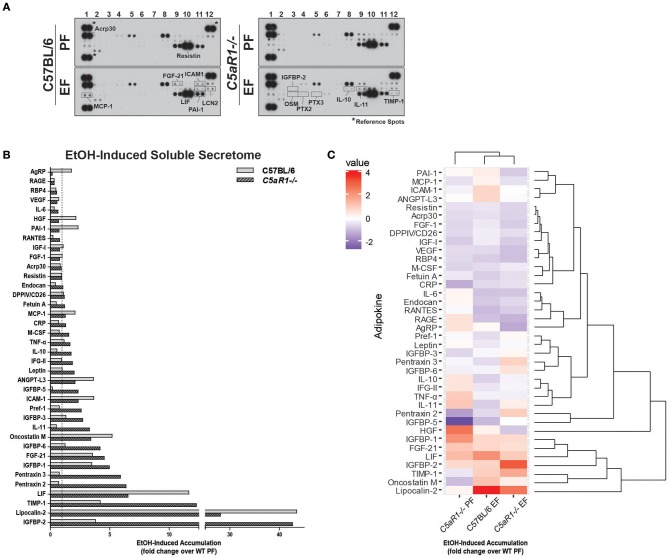
Ethanol and C5aR1 differentially modulates the soluble secretome from isolated adipocytes. WT and C5aR1−/− mice were allowed free access to ethanol (32%, d25) or pair-fed control diets. Adipocytes were isolated following collagenase digestion. Spontaneous secretion of adipokines was assessed in supernatants 60 min post-isolation. (A) Adipokine accumulation was measured using an adipokine array. Relative density was calculated using Image J; data were normalized to reference spots for each experimental group. Lighter exposures were used for more abundant adipokines (Acrp30, Resistin) and reference spots (data not shown). (B) Ethanol-fed groups are expressed as fold change of WT pair-fed adipocyte supernatants. (C) Heat maps illustrate the changes in concentration for adipokines between groups; data are expressed as fold change of WT pair-fed adipocyte supernatants. Fold changes are shown in the column to the left of the heat maps (least abundant = dark blue; most abundant = red). Hierarchical clustering (shown at the right of the heat map) revealed the similarities between treatment and genotype. Data are representative of pooled samples (n = 6–8) for each group. PF, pair-fed; EF, EtOH-fed.